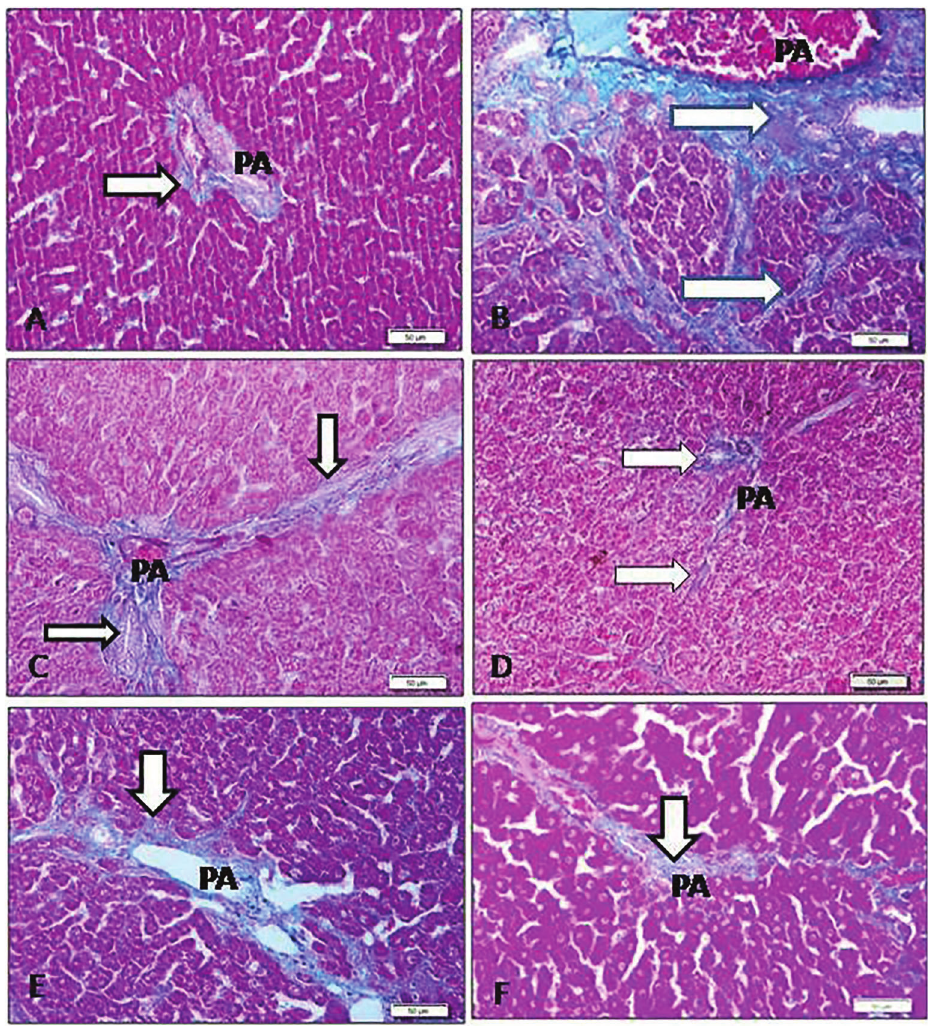
Figure 5. Sections of rat liver stained with Masson ’ s trichrome ( (cid:3) 600). A , Normal control group showing normal collagen distribution around portal area (PA). B , Thioacetamide group showing increased collagen deposition in the portal area (PA) and fi brous bridging between lobules (arrows). C and E , Lower doses of losartan and candesartan groups (5 and 0.1 mg/kg) showing potential improvement with decreased amount of collagen deposition at portal area (PA) and between lobules (arrows). D and F , Higher doses of losartan and candesartan groups (10 and 0.3 mg/kg) showing marked improvement with marked decrease of collagen deposition around portal area (PA), and absence of interlobular fi brosis (arrows). White arrows indicate newly proliferating fi